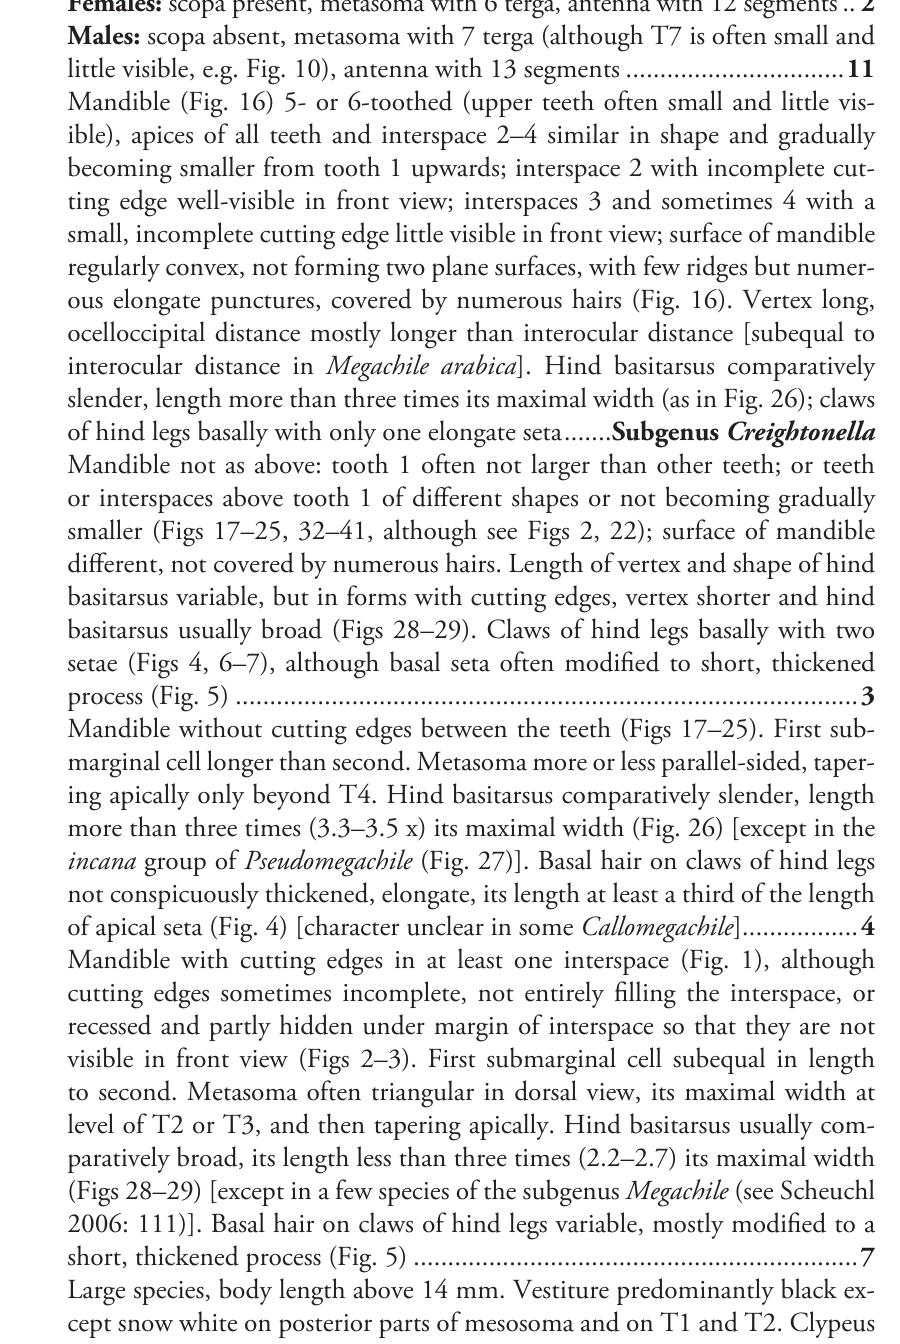
Females: scopa present, metasoma with 6 terga, antenna with 12 segments .. 2 – Males: scopa absent, metasoma with 7 terga (although T7 is often small and little visible, e.g. Fig. 10), antenna with 13 segments ................................ 11 2 Mandible (Fig. 16) 5- or 6-toothed (upper teeth often small and little vis- ible), apices of all teeth and interspace 2–4 similar in shape and gradually becoming smaller from tooth 1 upwards; interspace 2 with incomplete cut- ting edge well-visible in front view; interspaces 3 and sometimes 4 with a small, incomplete cutting edge little visible in front view; surface of mandible regularly convex, not forming two plane surfaces, with few ridges but numer- ous elongate punctures, covered by numerous hairs (Fig. 16). Vertex long, ocelloccipital distance mostly longer than interocular distance [subequal to interocular distance in Megachile arabica ]. Hind basitarsus comparatively slender, length more than three times its maximal width (as in Fig. 26); claws of hind legs basally with only one elongate seta ....... Subgenus Creightonella – Mandible not as above: tooth 1 often not larger than other teeth; or teeth or interspaces above tooth 1 of different shapes or not becoming gradually smaller (Figs 17–25, 32–41, although see Figs 2, 22); surface of mandible different, not covered by numerous hairs. Length of vertex and shape of hind basitarsus variable, but in forms with cutting edges, vertex shorter and hind basitarsus usually broad (Figs 28–29). Claws of hind legs basally with two setae (Figs 4, 6–7), although basal seta often modified to short, thickened process (Fig. 5) ........................................................................................... 3 3 Mandible without cutting edges between the teeth (Figs 17–25). First sub- marginal cell longer than second. Metasoma more or less parallel-sided, taper- ing apically only beyond T4. Hind basitarsus comparatively slender, length more than three times (3.3–3.5 x) its maximal width (Fig. 26) [except in the incana group of Pseudomegachile (Fig. 27)]. Basal hair on claws of hind legs not conspicuously thickened, elongate, its length at least a third of the length of apical seta (Fig. 4) [character unclear in some Callomegachile ]................. 4 – Mandible with cutting edges in at least one interspace (Fig. 1), although cutting edges sometimes incomplete, not entirely filling the interspace, or recessed and partly hidden under margin of interspace so that they are not visible in front view (Figs 2–3). First submarginal cell subequal in length to second. Metasoma often triangular in dorsal view, its maximal width at level of T2 or T3, and then tapering apically. Hind basitarsus usually com- paratively broad, its length less than three times (2.2–2.7) its maximal width (Figs 28–29) [except in a few species of the subgenus Megachile (see Scheuchl 2006: 111)]. Basal hair on claws of hind legs variable, mostly modified to a Large species, body length above 14 mm. Vestiture predominantly black ex- cept snow white on posterior parts of mesosoma and on T1 and T2.